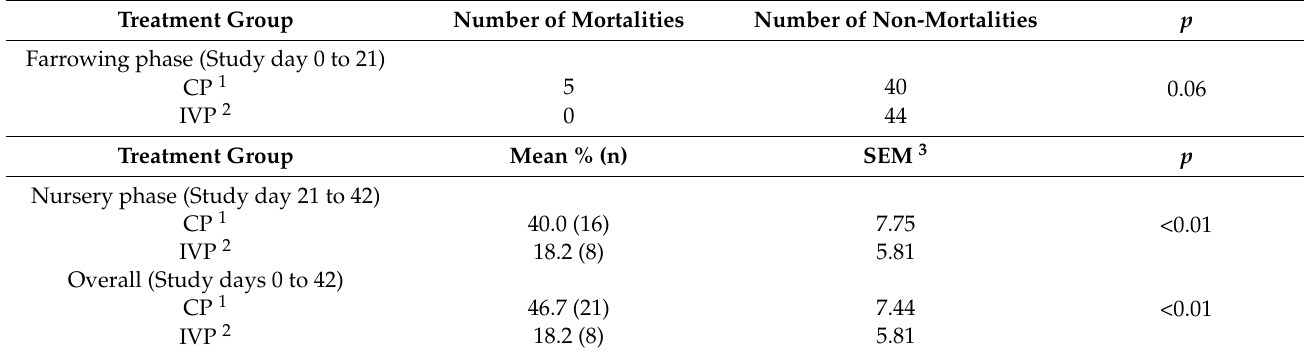
Table 2. Mortality by treatment groups among pigs used to test core antigen bacterin with an immunostimulant on health and performance outcomes when challenged with enteric and respiratory pathogens.